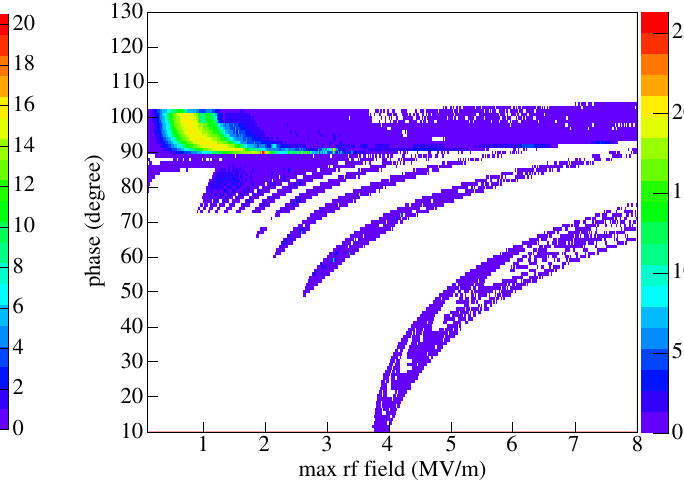
FIG. 16. (Color) Electron multiplication factor as a function of the maximum rf field and the emission phase with no applied solenoid field. The primary and secondary electrons were tracked for 100 rf cycles. For electrons starting at a maximum rf field between 0.1 and 1 : 8 MV = m and at an rf phase between 90 (cid:2) and 96 (cid:2) , the multiplication factor is higher than 5 for this time period. The white area shows no multipacting